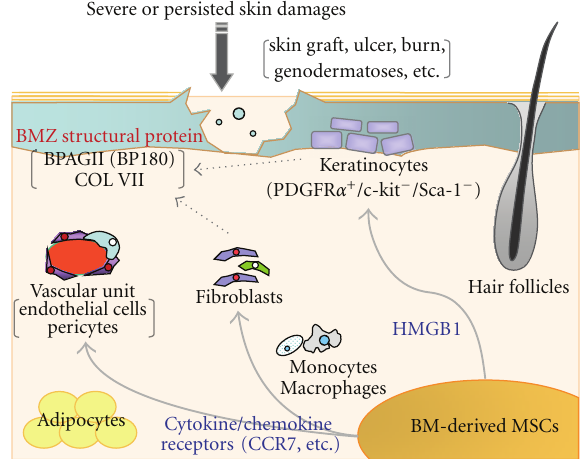
Figure 2: Transdi ff erentiation of bone-marrow-derived mesenchy- mal stem cells (MSCs) into the multiple skin component cells. The particular subset(s) of allogenically transferred MSCs, a PDGFR α + /c-kit − /Sca-1 − lineage, can di ff erentiate into the keratin- marker-positive epidermal keratinocytes via a paracrine action of HMGB1. In another cascade, the transdi ff erentiation activity of the MSCs into other skin components such as vasculature (endothelial cells and pericytes) and dermal fibroblasts—albeit much lesser with monocytes, macrophages, and adipocytes—is accelerated by certain cytokine/chemokine signalling, especially CCR7-SLC/CCL21 path- way. These BM-derived multiple cell lineages can be a potential source for supplying skin structural molecules, such as type VII collagen (COLVII) and type XVII collagen (BPAGII; BP180), both of which are essential anchoring molecules in the basement membrane zone